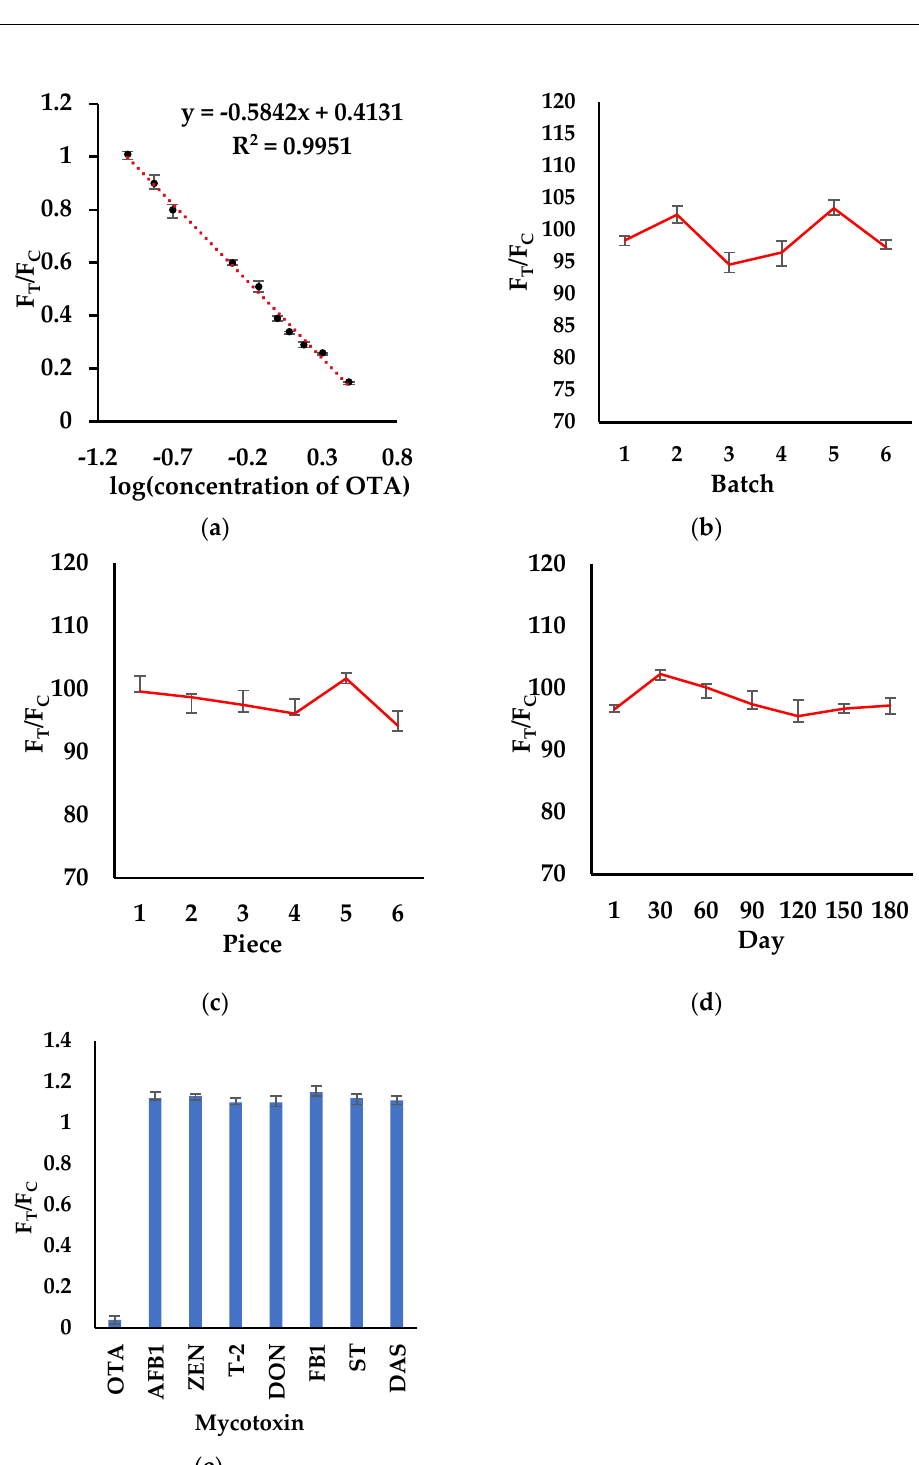
Table 1. Comparison between this proposed iPOCT and UPLC-MS/MS method using wheat. Sample OTA Spiked Level (ng/mL)